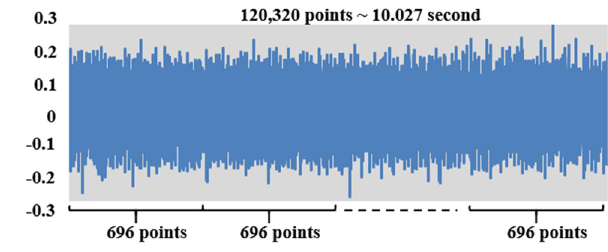
Figure 9: Signal Division.